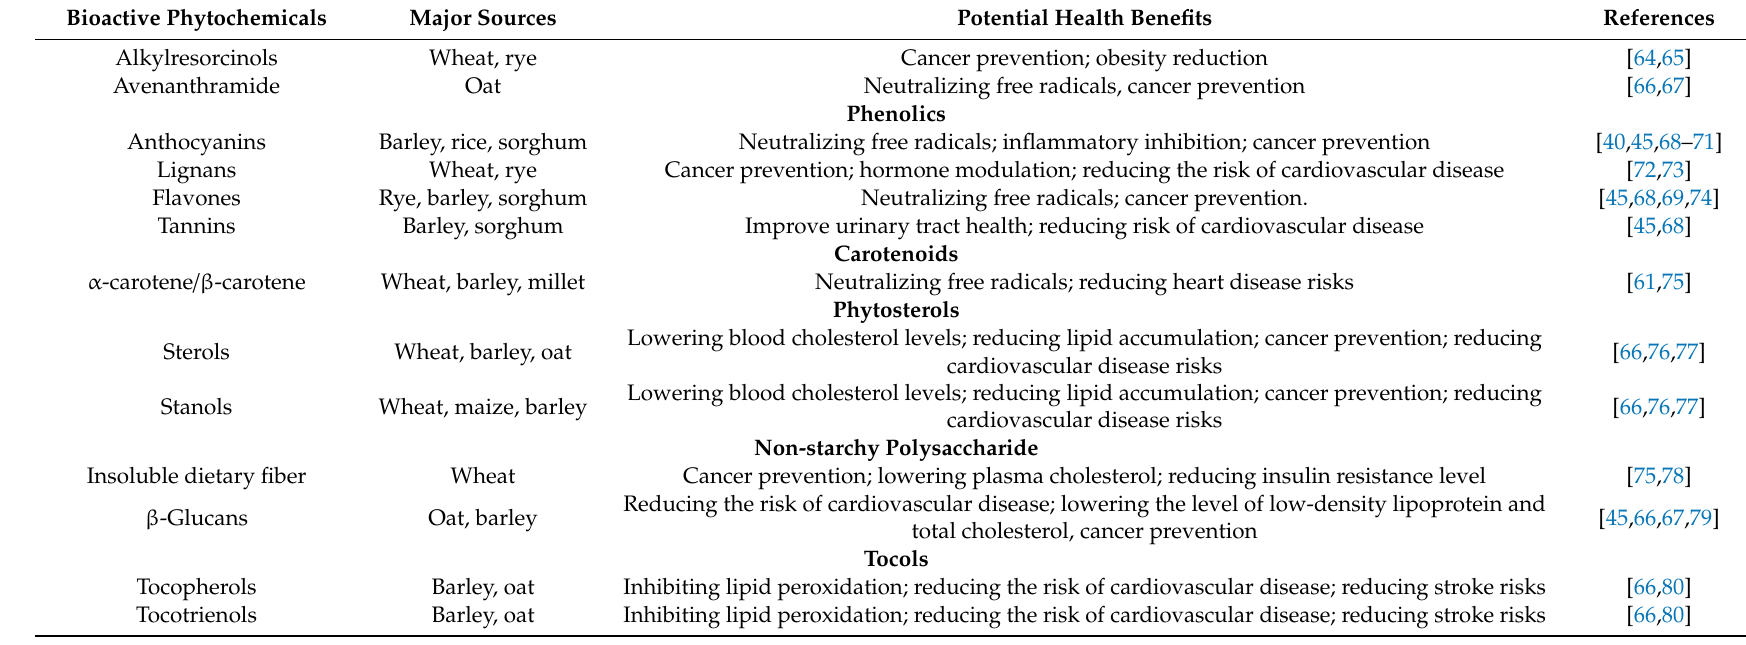
Table 2. The potential health benefits of bioactive phytochemicals extracted from whole